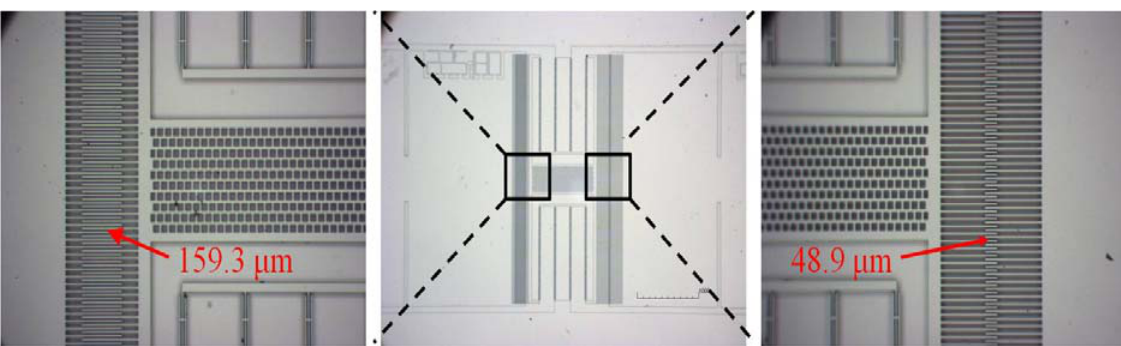
and A = 7.414 × 10 − 6 m 2 anch